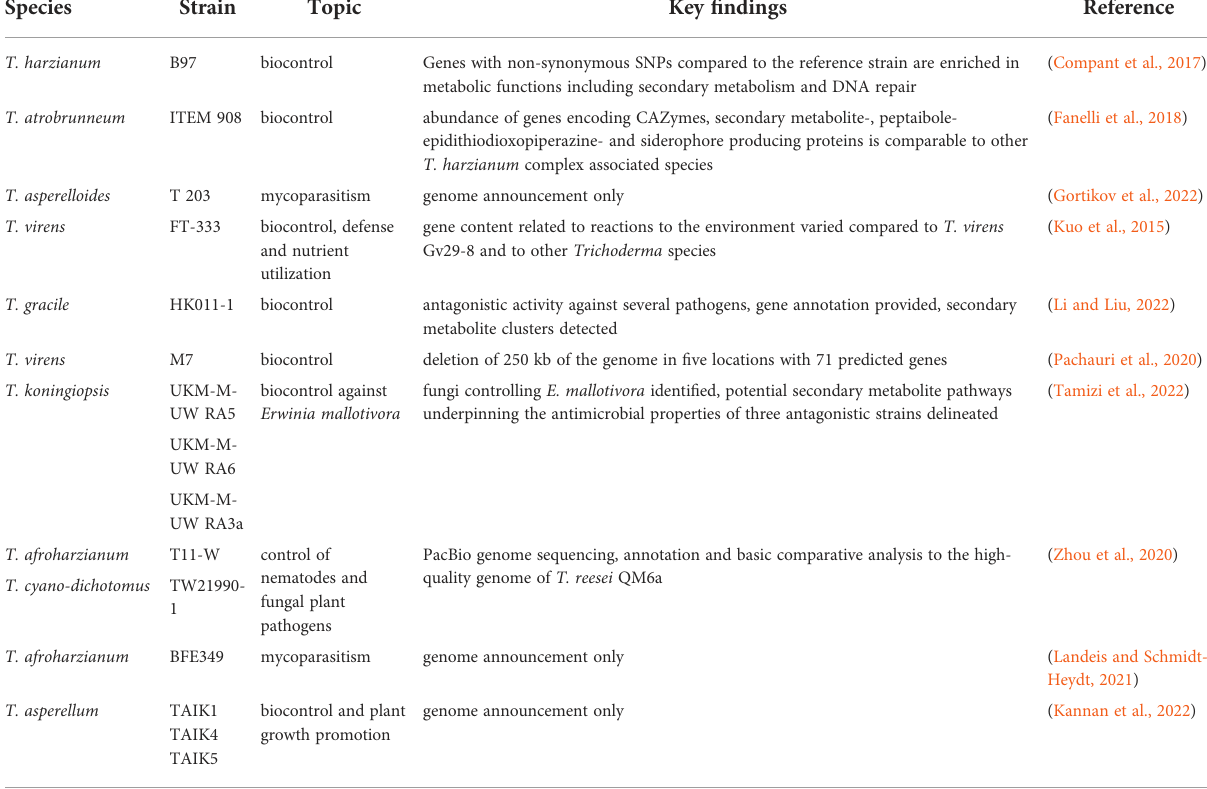
TABLE 1 Recent genome level analyses of Trichoderma spp. targeted at biocontrol related issues.